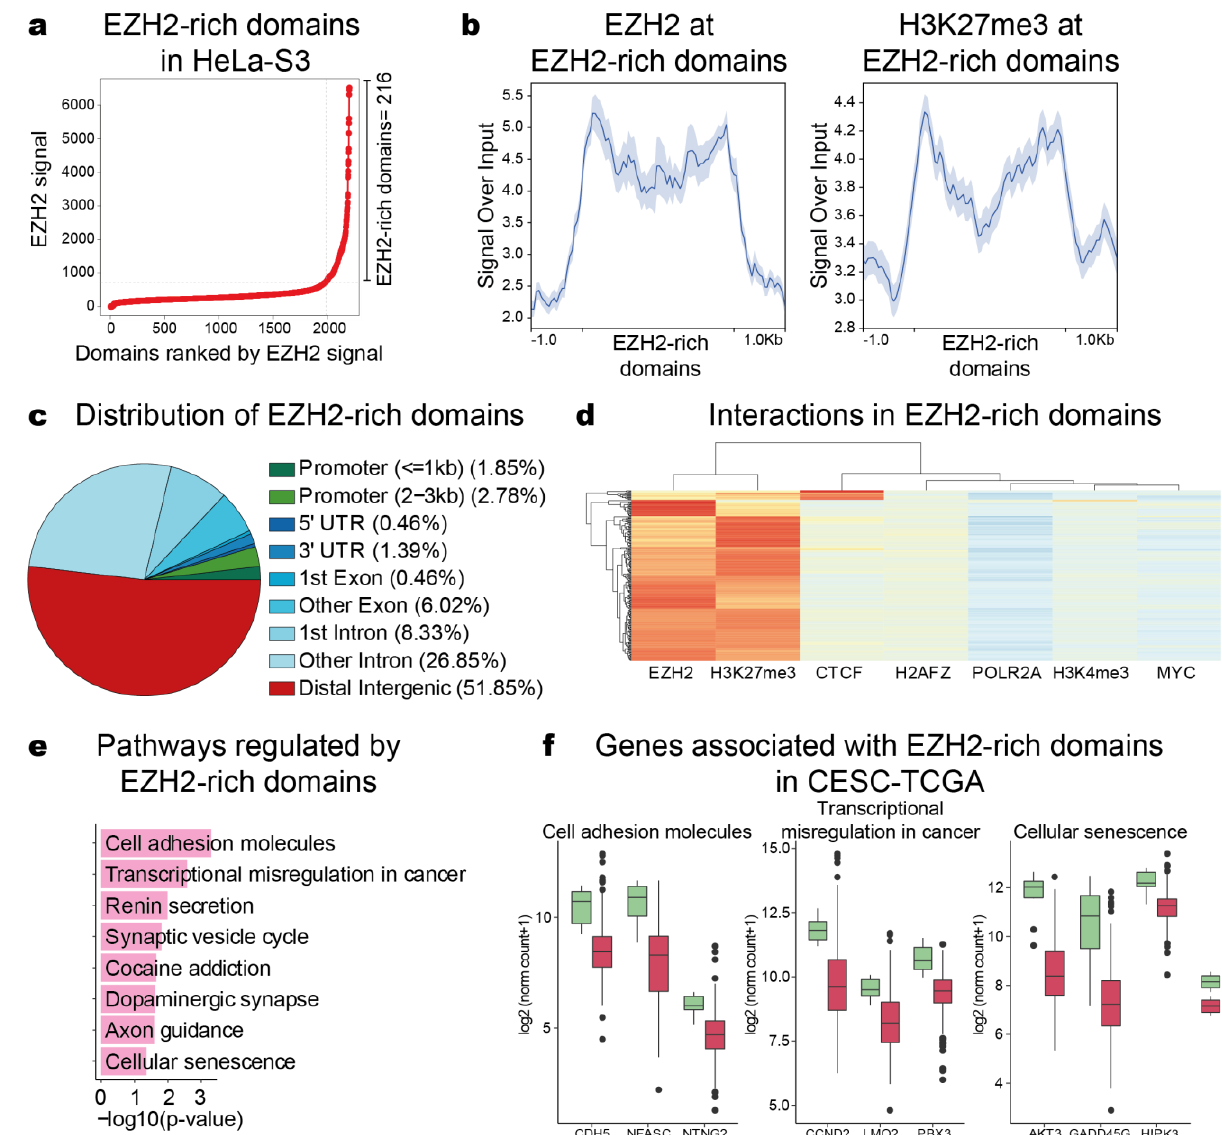
Figure 4: EZH2-rich domains promote transcriptional repression in cervical cancer. a) EZH2-rich domains in HeLa- S3 cells. b) Profile plots of EZH2 and H3K27me3 enrichment at EZH2-rich do- mains in HeLa-S3 cells. The signal inten- sity of EZH2 and H3K27me3 are shown concerning the input. c) Genomic anno- tation of EZH2-rich domains in HeLa-S3. d) Hierarchical clustering of EZH2-rich domains enriched with EZH2, H3K27me3, CTCF, H2A.Z, POLR2A, H3K4me3, and MYC in HeLa-S3. e) Functional annotation of genes near to EZH2-rich domains. The most significant pathways are shown. We considered a p- value <0.05 as statistically significant. f) Expression of genes associated with EZH2-rich domains in TCGA and GTEx patients. We analyzed genes near EZH2- rich domains in HeLa-S3 associated with cell adhesion molecules, transcriptional misregulation in cancer, and cellular se-